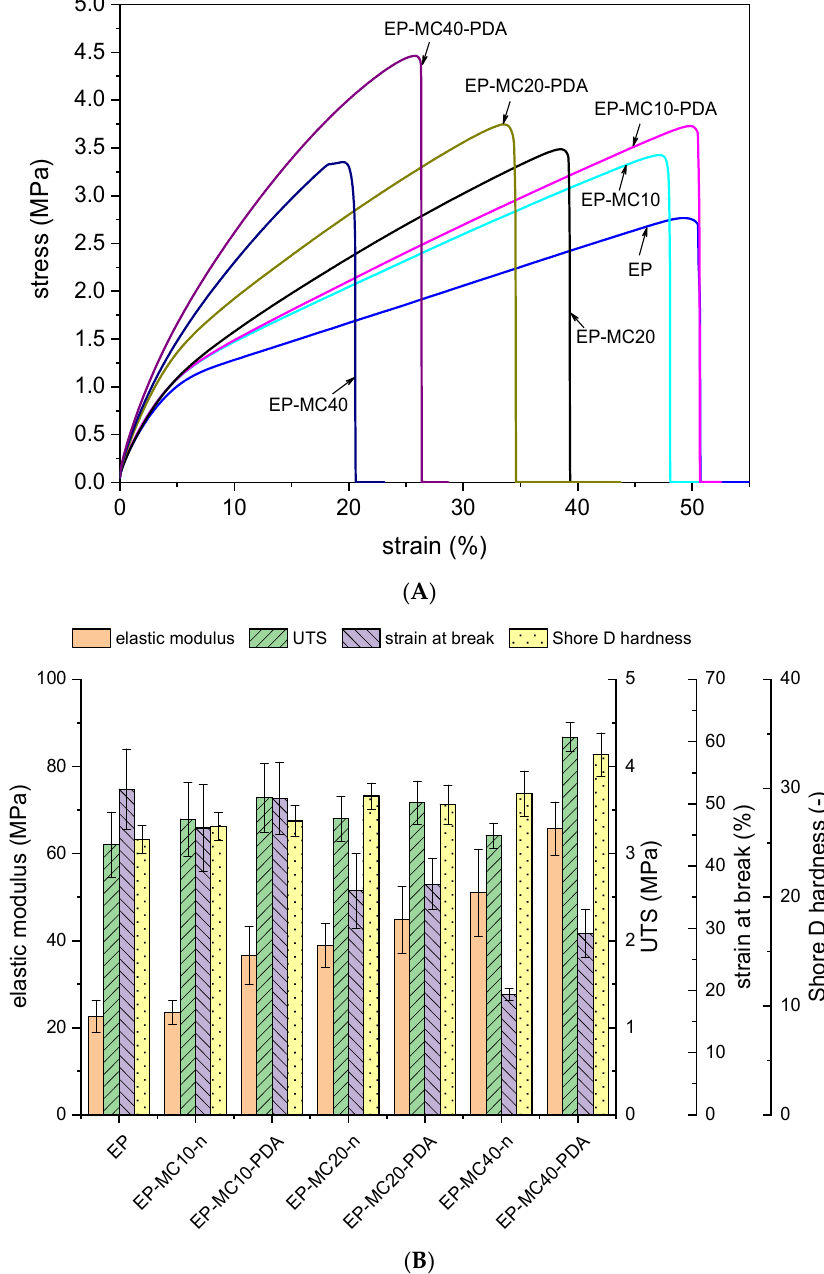
Figure 8. Results of quasistatic tensile tests and Shore D hardness tests on the prepared composites. ( A ) Representative stress–strain curves; ( B ) elastic modulus, ultimate tensile strength (UTS), strain at break, and Shore D hardness for the prepared composites (mean value and standard deviation).